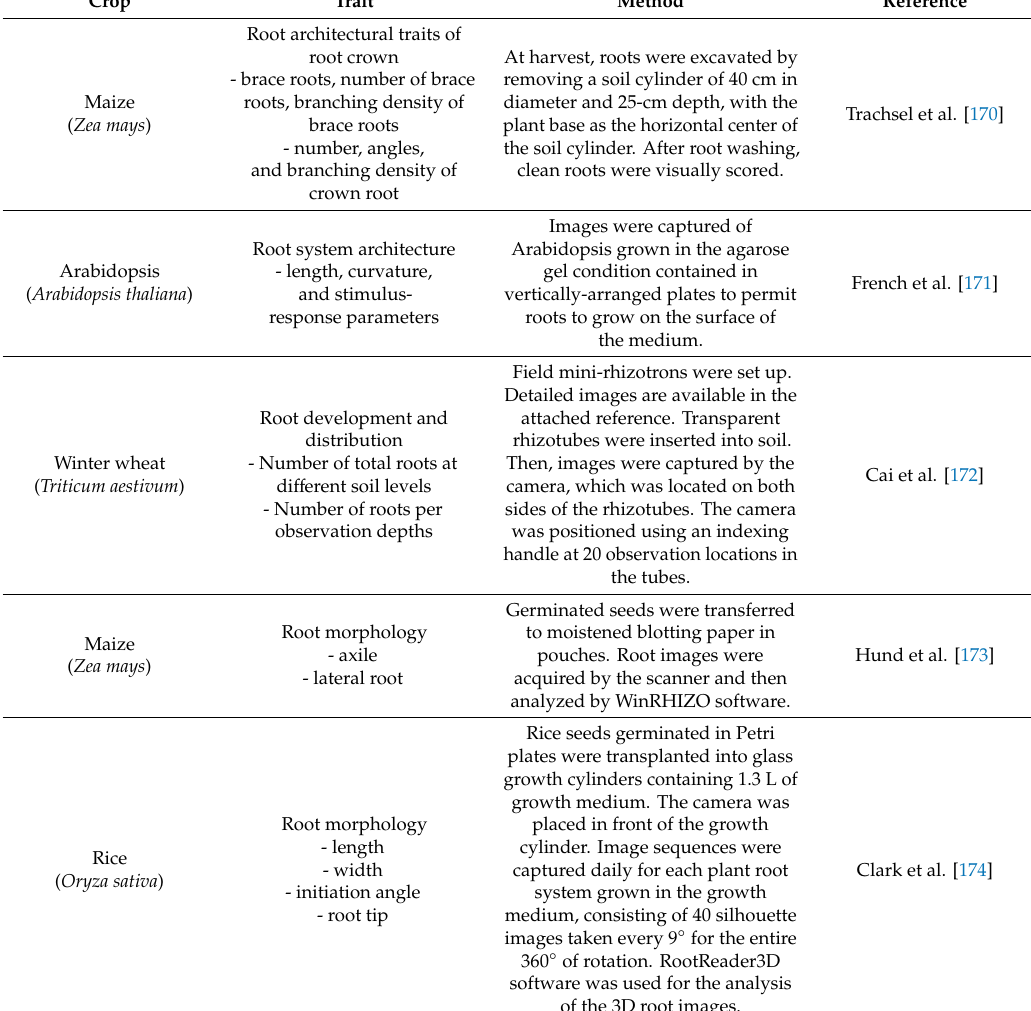
Table 2. List of root phenotyping methods in various